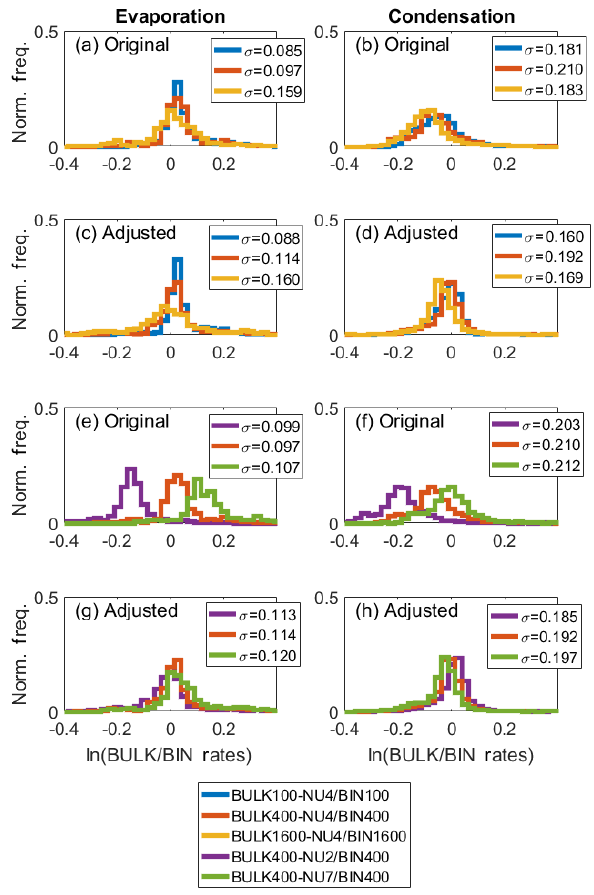
Figure 3. The ratio of the BULK to BIN (a–c) condensation and (d–f) evaporation rates as a function of saturation ratio ( S) and in- tegrated diameter ( ND ) for each pair of simulations. Note the dif- ferences in axes